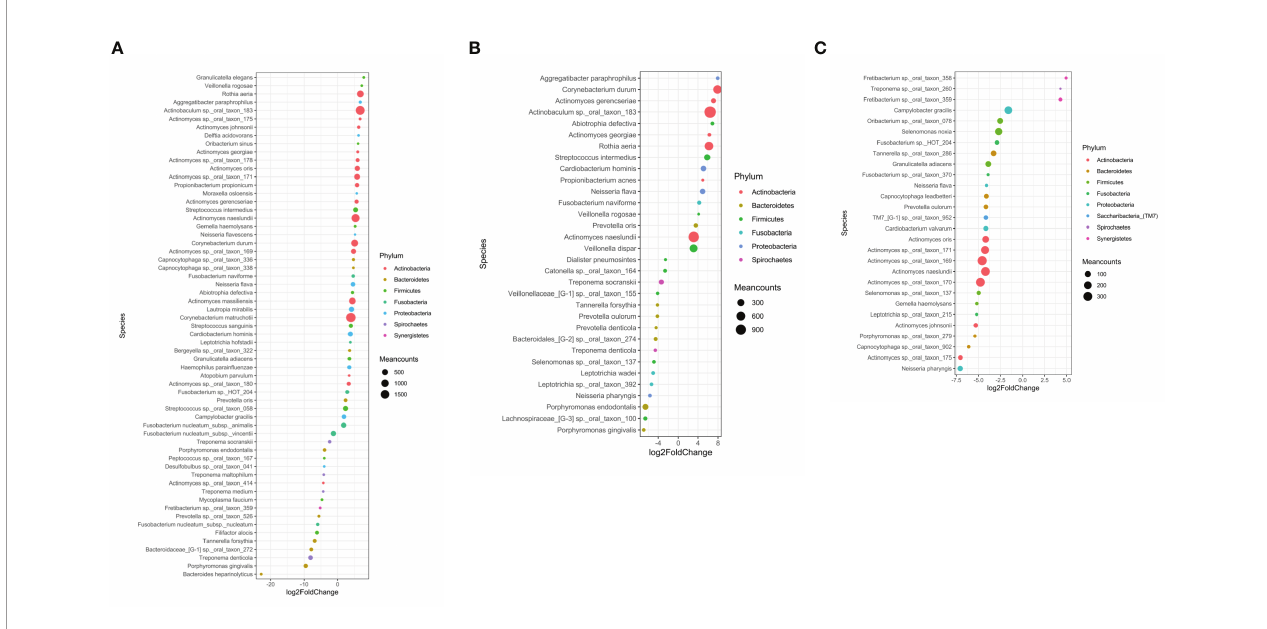
FIGURE 3 | Differentially abundant operational taxonomic units (OTUs) in three comparisons. Each circle represents one OTU (bacterial species). The OTUs are color-coded based on the phylum to which they belong and plotted based on their log2 fold change in each comparison. The size of the circle is proportional to the mean count of each species. All differentially abundant OTUs in each comparison are listed. (A) Healthy (H) vs . Periodontitis before non-surgical therapy (P); (B) Healthy (H) vs . Periodontitis after non-surgical therapy (A); (C) Periodontitis before non-surgical therapy (P) vs . Periodontitis after non-surgical therapy (A). In these comparisons, the second group is the reference group. The fold change is calculated by dividing the bacterial abundance in the fi rst group by the bacterial abundance in the second group (H/P, H/A, P/A respectively). These graphs demonstrate different microbial compositions between the three groups.